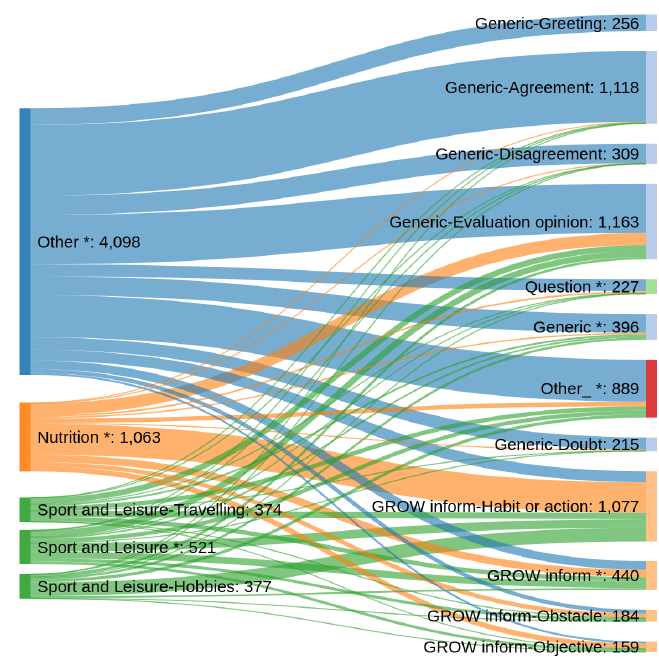
Figure 5. Relationship between intent and topic